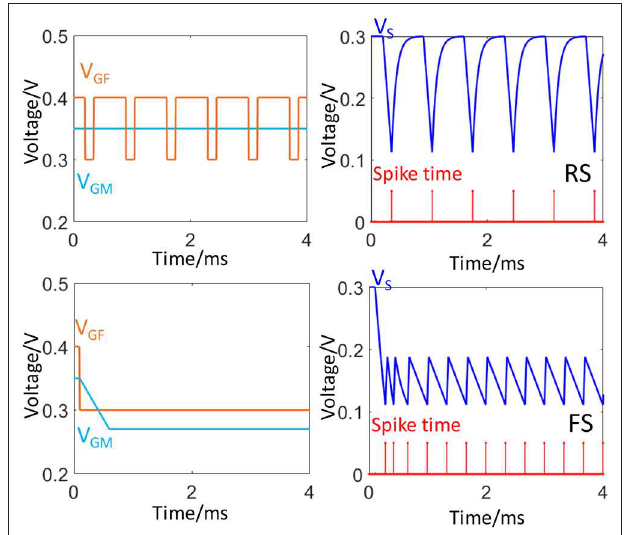
FIGURE 3 | Two neural firing patterns, FS and RS. The plots on the left column show the waveforms of input signals to V GF and V GM . The right column plot the waveforms of V S (blue) and corresponding timing of spike train